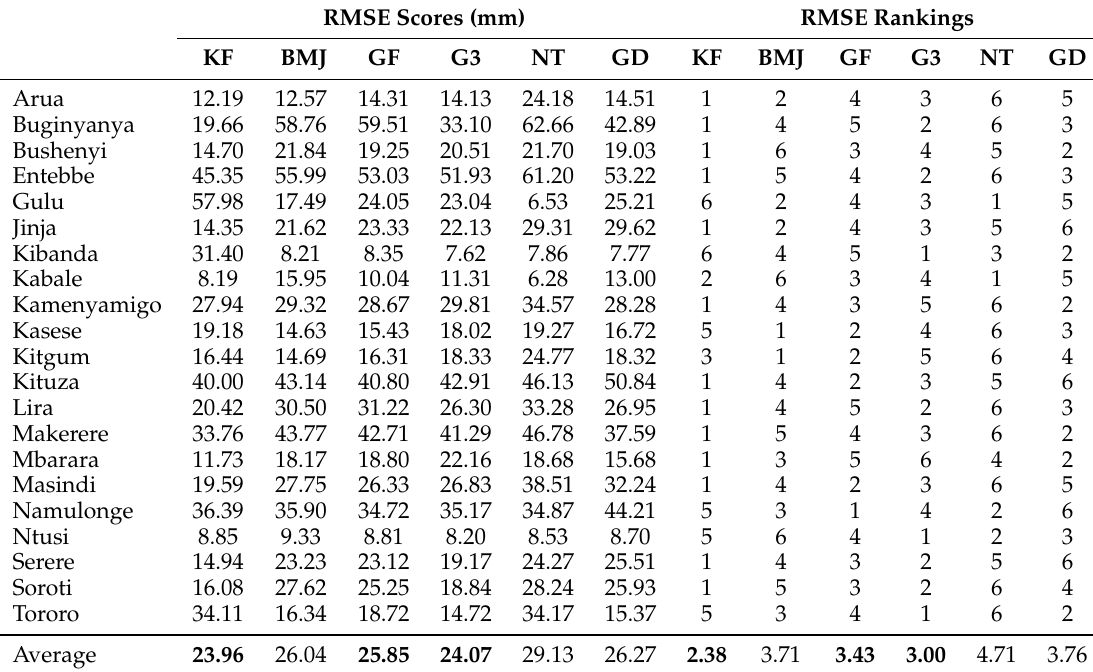
Table 1. The RMSE of simulations with the different cumulus parametrization